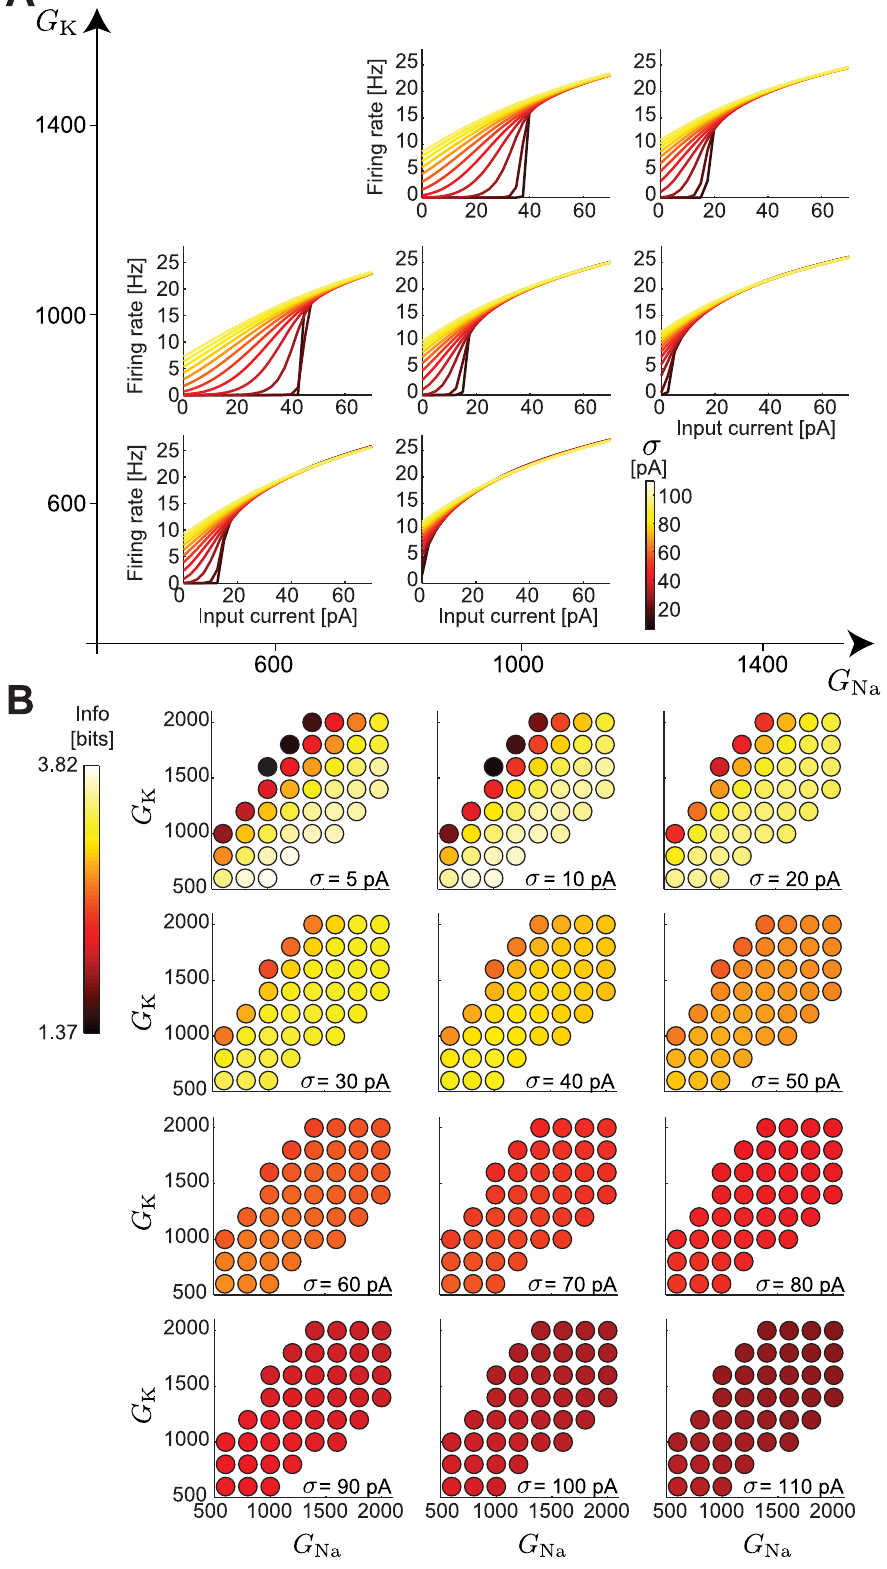
Figure 2. f – I curves and information as a function of individual maximal Na and Kconductances. A. The f – I curves for different maximal Na and K conductances, G Na and G K , in pS/ m m 2 (compare to Figure 1C,D). B. The information for the different models as a function of s (compare to Figure 1F). doi:10.1371/journal.pcbi.1003962.g002 PLOS Computational Biology |